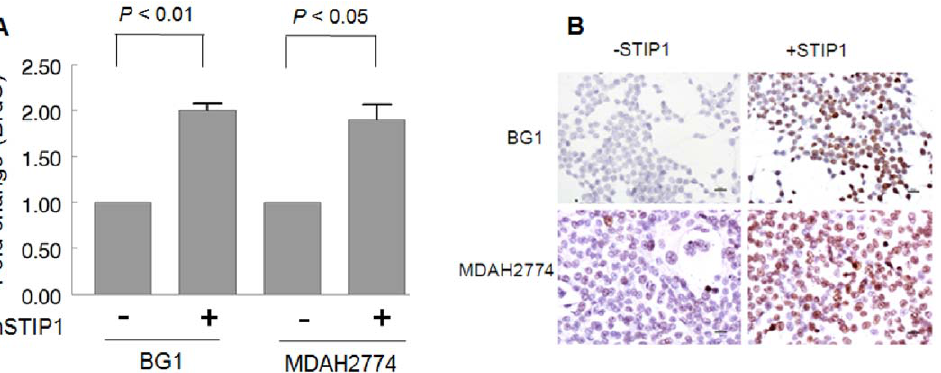
Figure 4. The treatment of ovarian cancer cells with recombinant human STIP1 (rhSTIP1) stimulates cell proliferation. Two ovarian cancer cell lines (BG1 and MDAH2774) were treated with 400 nM of rhSTIP1 and analyzed by BrdU incorporation (A) and Ki67 immunostaining (B). Ki67-positive cells are shown in brown color; scale bars represent 20 m .